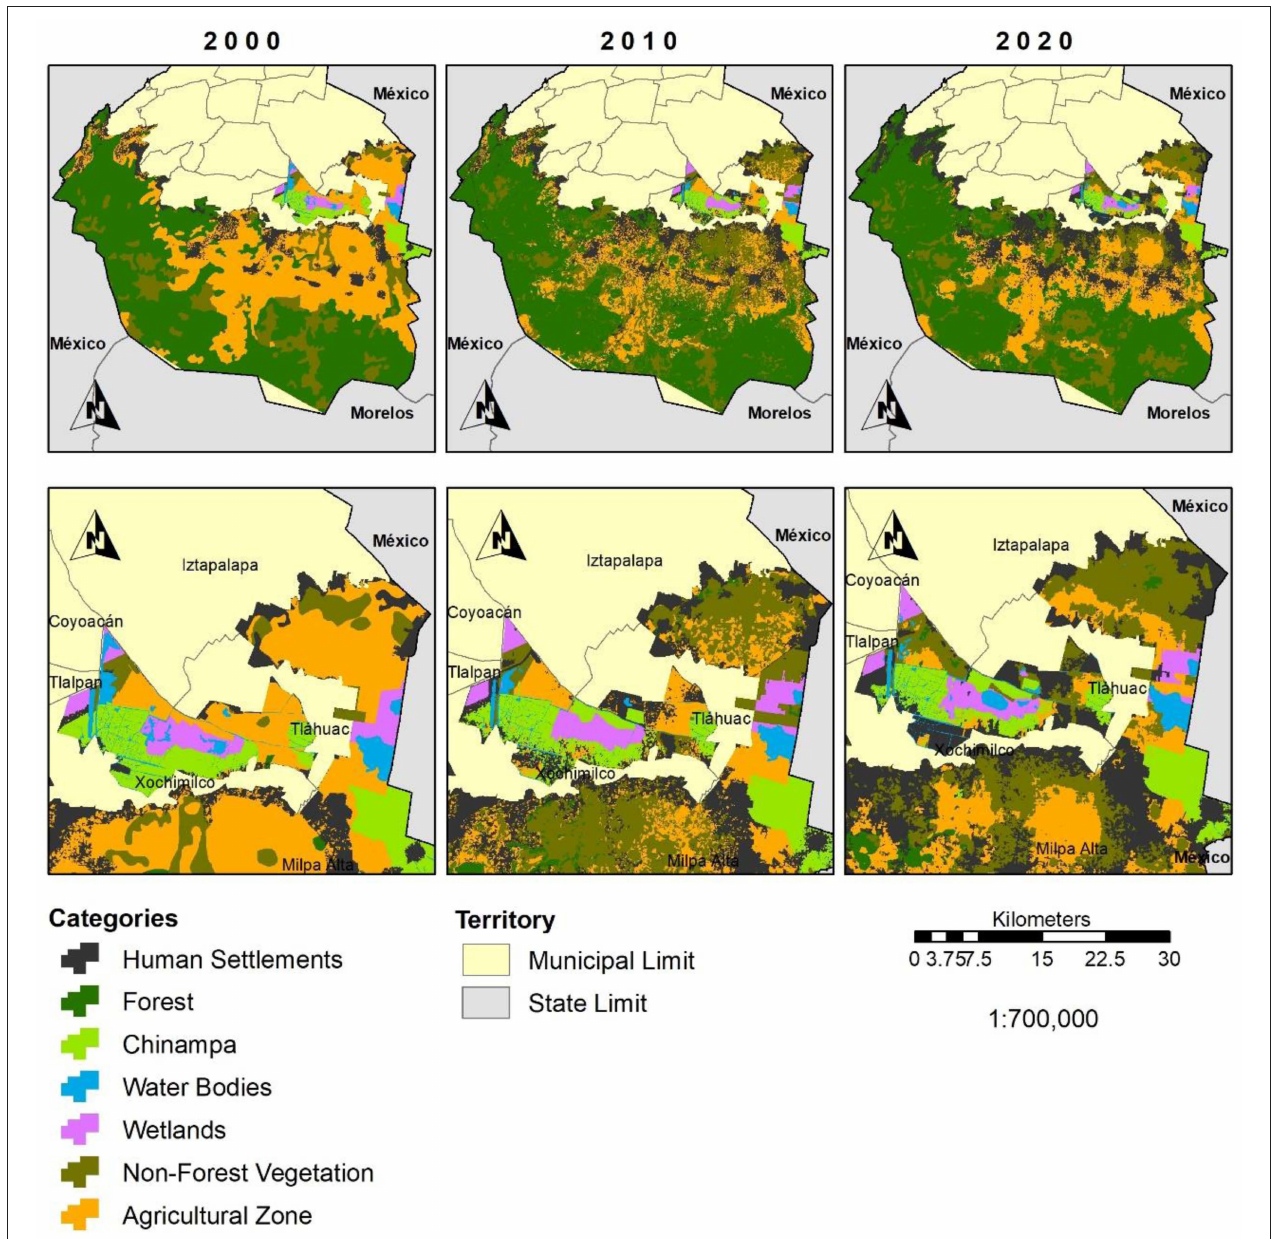
FIGURE 4 | The conservation zone: evolution of land use and vegetation change, 2000–2020. Elaborated from land use and vegetation layers of Serie II from INEG I (National Institute of Statistics and Geography, 2001); GDF (2012) Atlas Geografico del Sue lo de Conservaci6n del Distrito Federal; and Esri Land Cover,